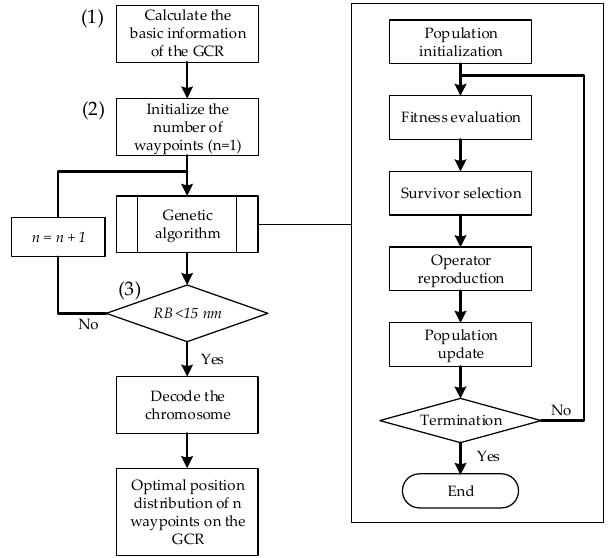
Figure 3. Schematic diagram of the GA method process.